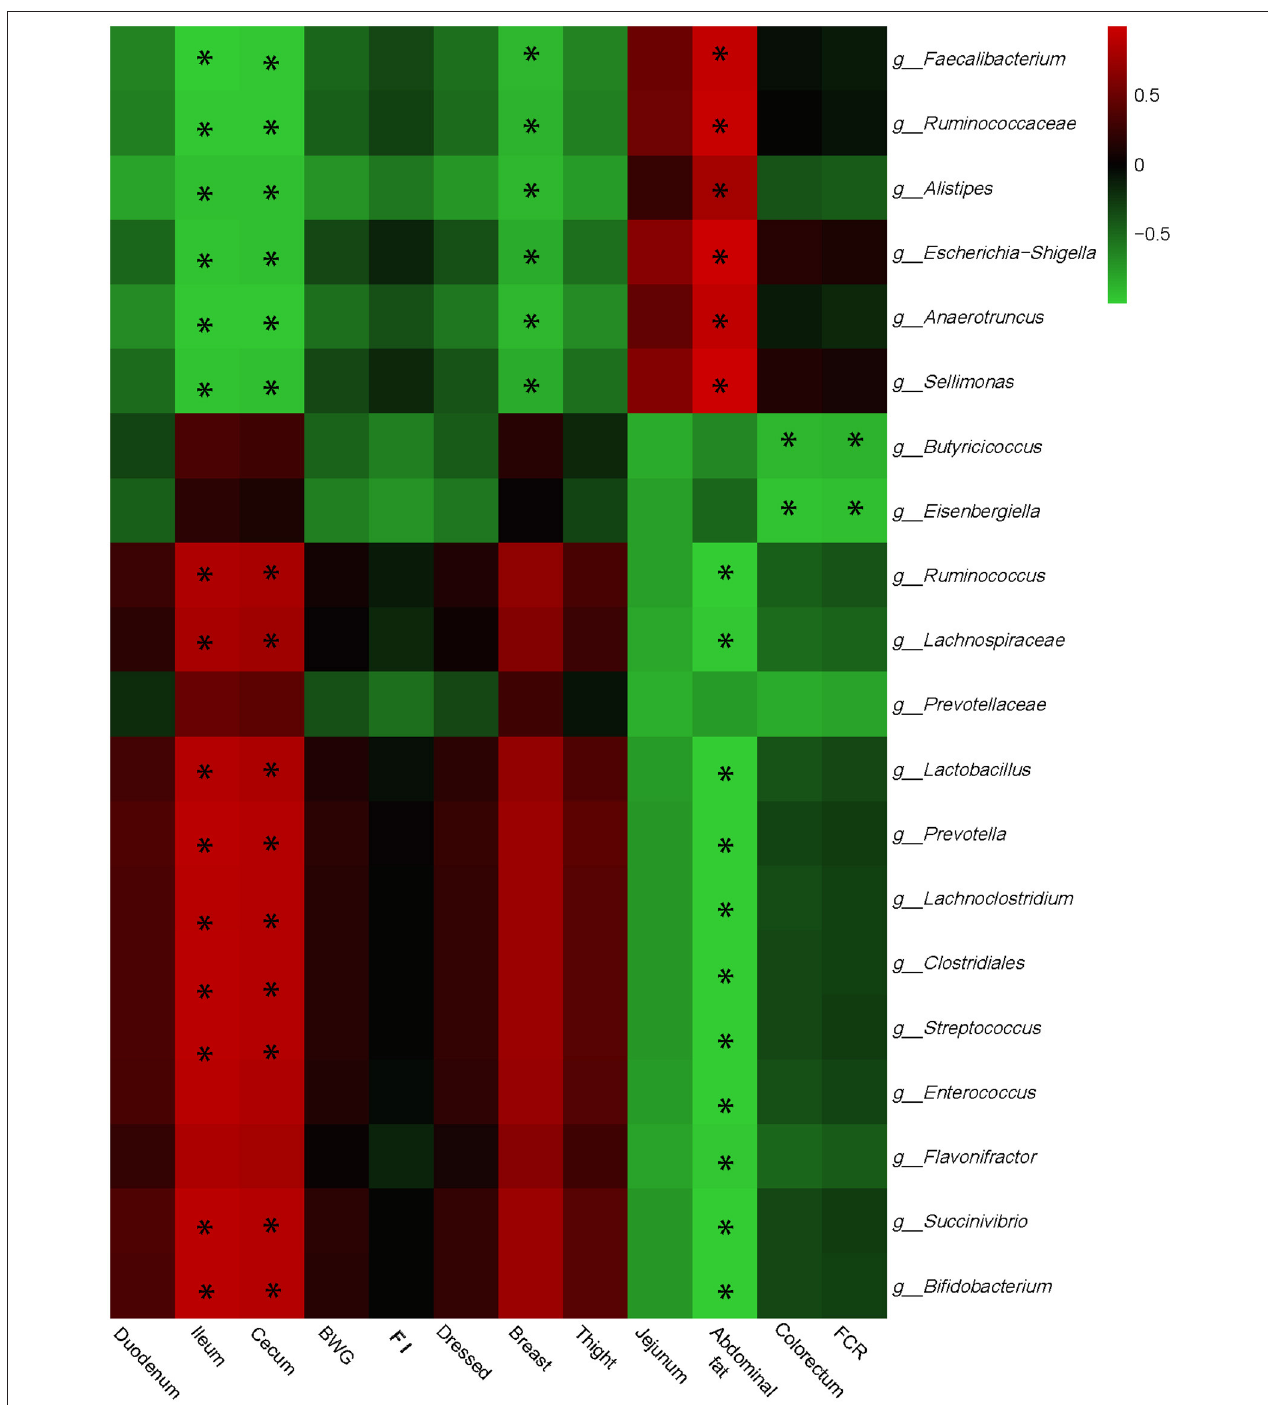
FIGURE 3 | Correlation analyses between abundances of cecal bacteria and growth performances, carcass performances, and intestinal development parameters on the level of genera. The red color represents positive correlation while the green color represents a negative correlation. *Means a significant correlation (| r | > 0.55, P <